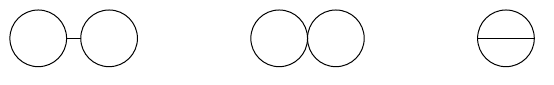
Figure 2 . Double-tadpoles, cactus and melonic type